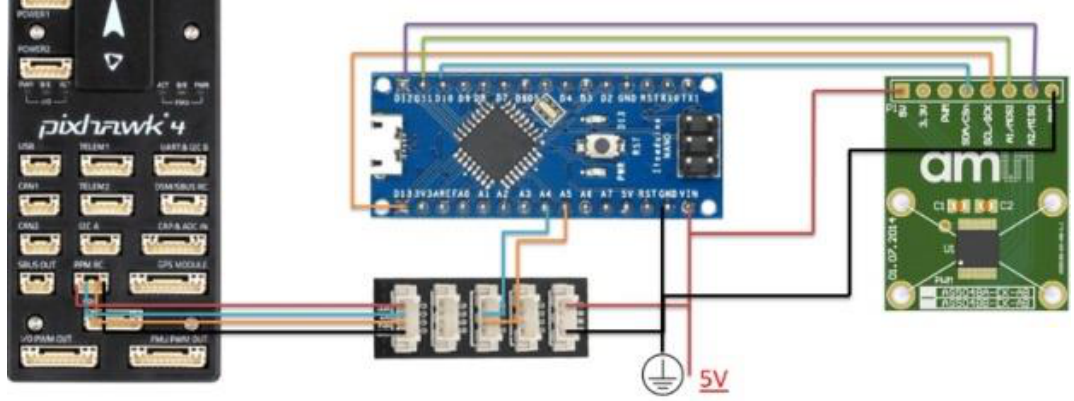
Figure 1. Pixhawk4 board, Arduino Nano boar, As5048a